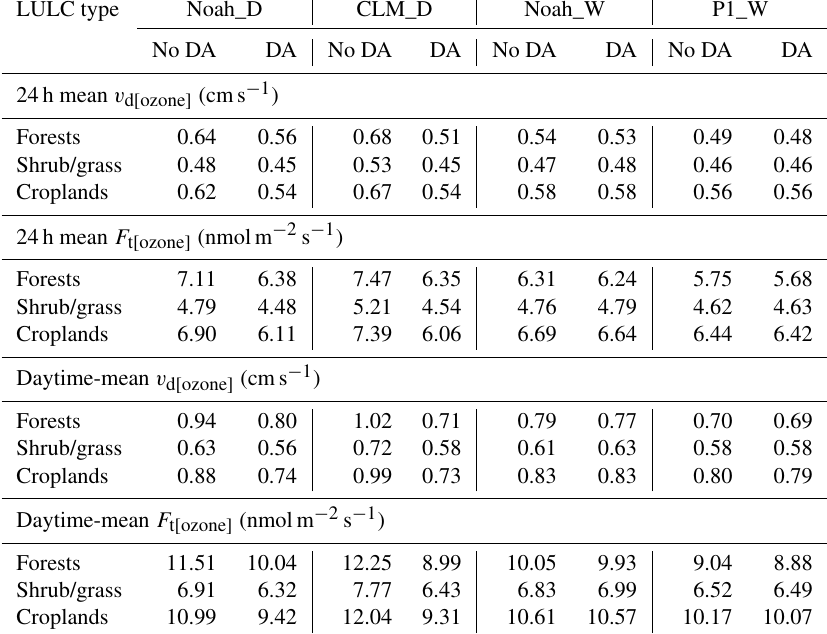
Table 5. The 24h and daytime mean O 3 deposition velocity ( v d [ ozone ] ) and flux ( F t [ ozone ] ) for three LULC groups, from various model cases.